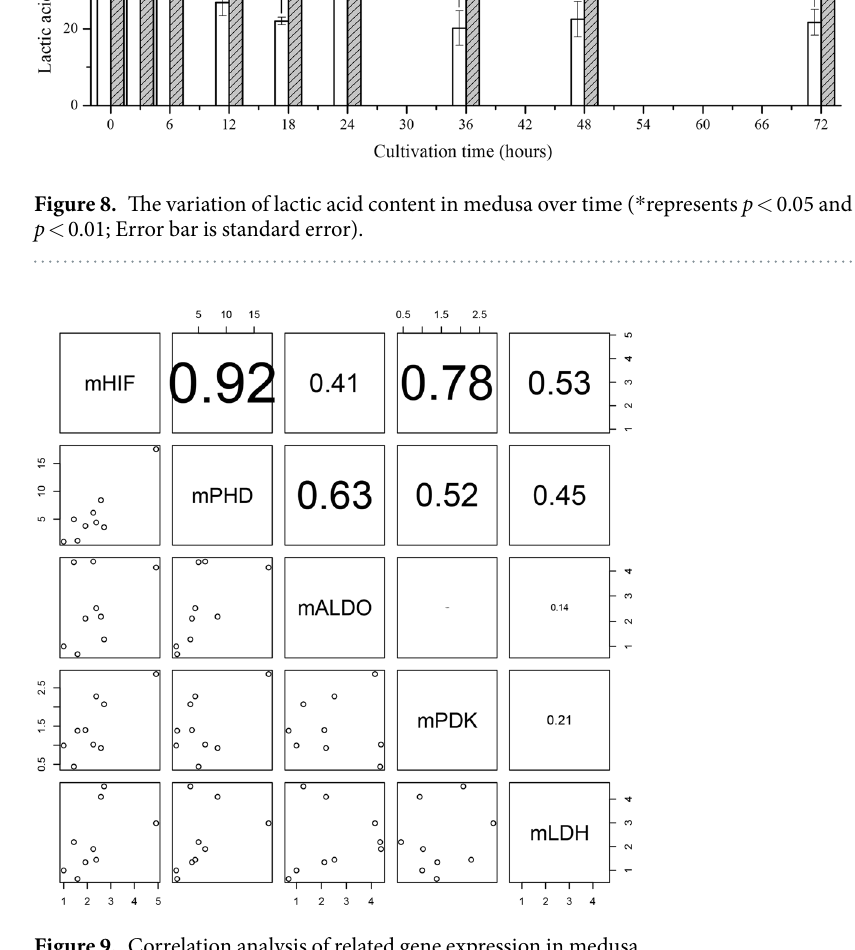
Figure 9. Correlation analysis of related gene expression in